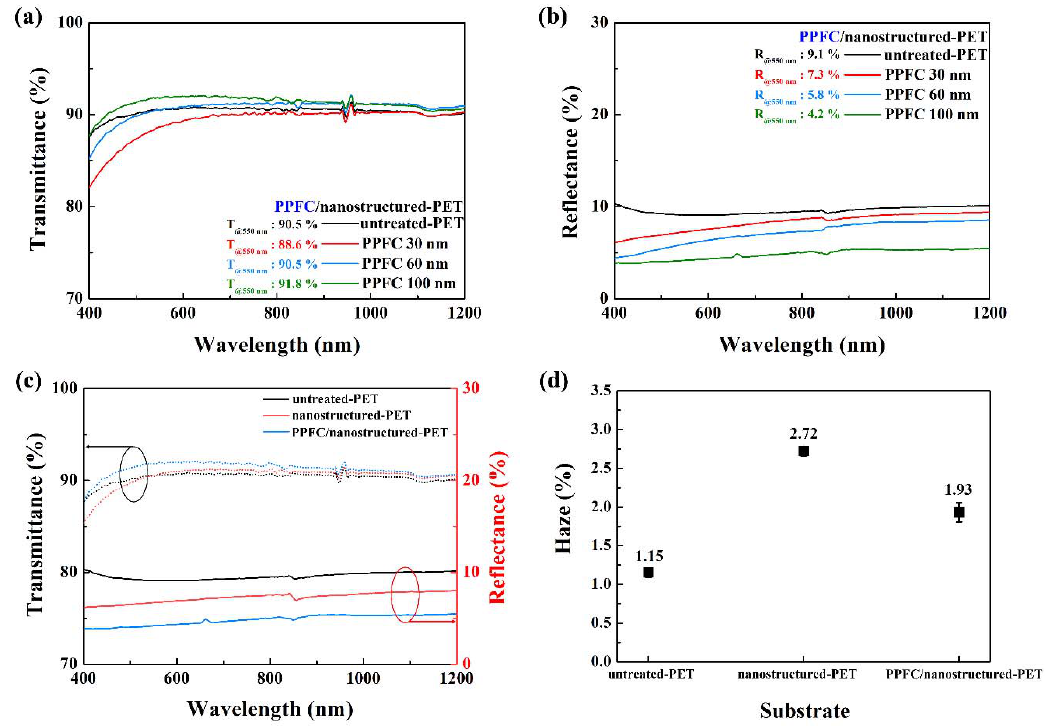
Figure 4. Optical characteristics of PPFC / nanostructured-PET. ( a ) Optical transmittance and ( b ) reflectance spectra of PPFC / nanostructured-PET as a function of PPFC coating layer thickness, ( c ) optical transmittance and reflectance spectra of nanostructured-PET and PPFC / nanostructured-PET, and ( d ) haze of untreated-PET, nanostructured-PET, and PPFC /